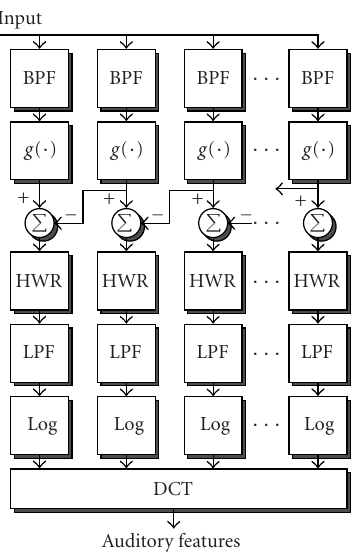
Figure 5: The bandpass-filtered version of the input is nonlinearly compressed and fed back to the input. The di ff erence operation be- tween lower and higher channels approximates a spatial derivative. The half-wave rectification followed by the smoothing filter picks out the peak. Log compression is performed followed by the DCT to decorrelate the